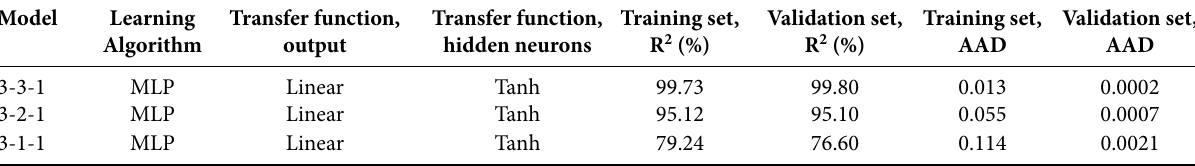
Table 4. Significant ANN architectures and their effects on the estimation and prediction of lipase activity (Y). Model Learning Transfer function, Transfer function, Training set, Algorithm output hidden neurons